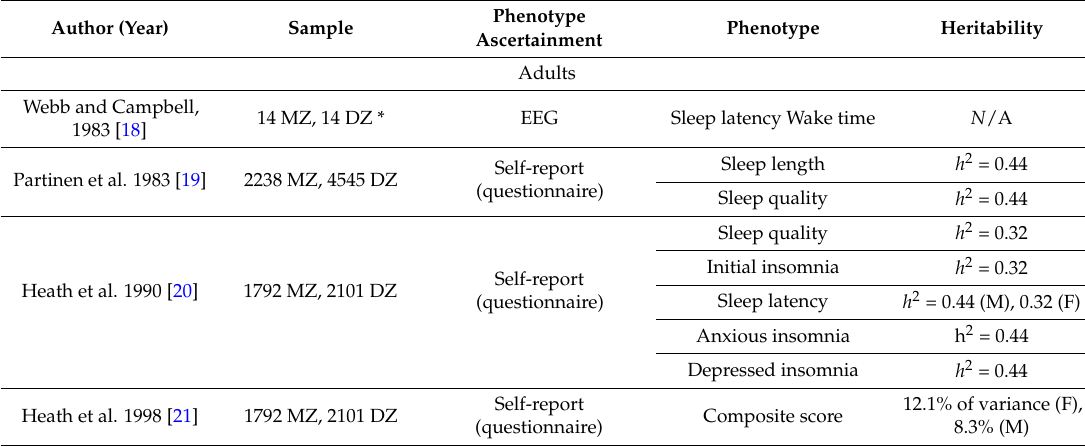
Table 2. Twin studies of insomnia